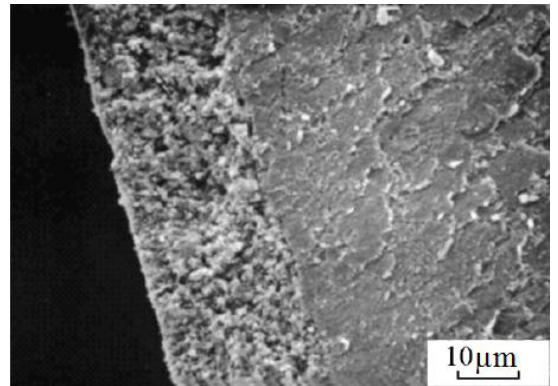
Figure 53. A layer of TiB electrochemical